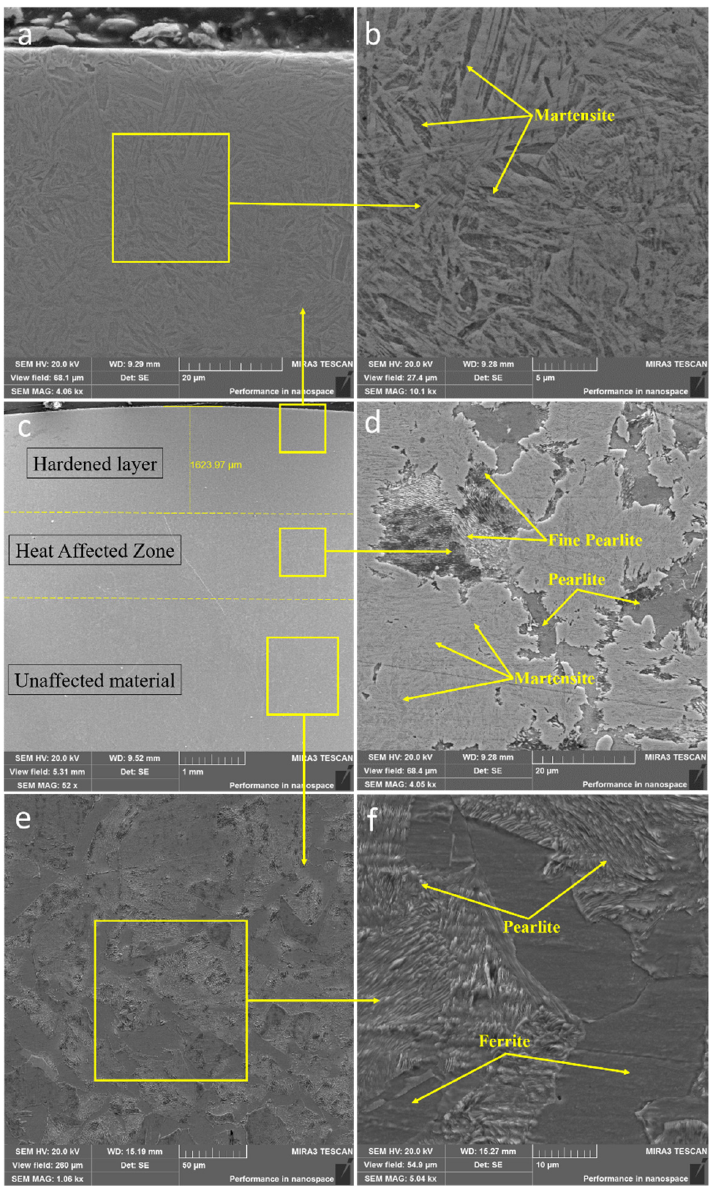
Figure 7. SEM images of the cross-section of sample No.2. ( a ) hardened layer at ×4000 and ( b ) ×10,000, ( c ) micrography at ×50, ( d ) heat affected zone at ×4000, ( e ) unaffected material at ×1000 and ( f ) ×5000.